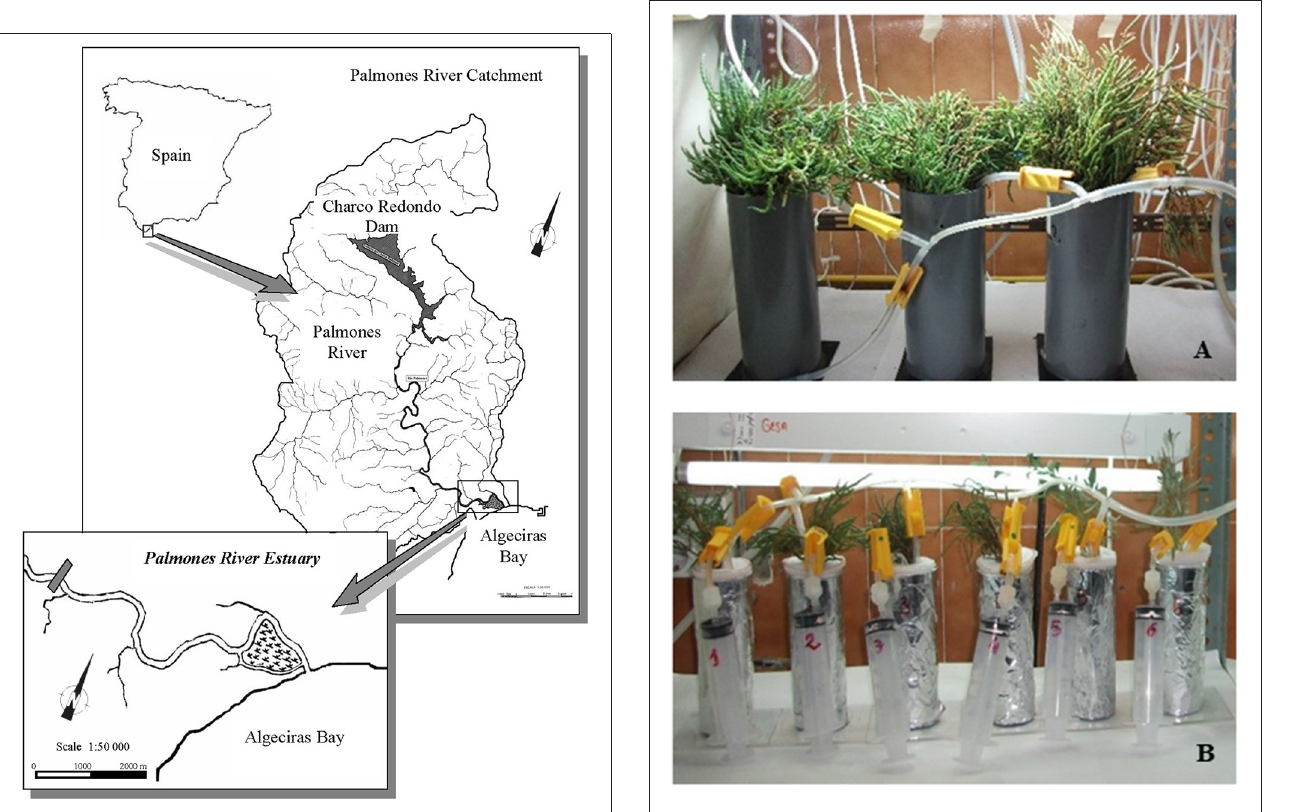
FIGURE 1 | Map of the location of the study